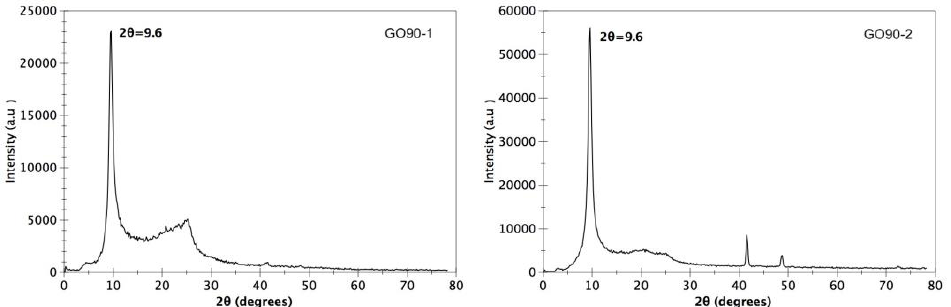
Figure 3. XRD pattern of graphene oxide dried at 60 °C.